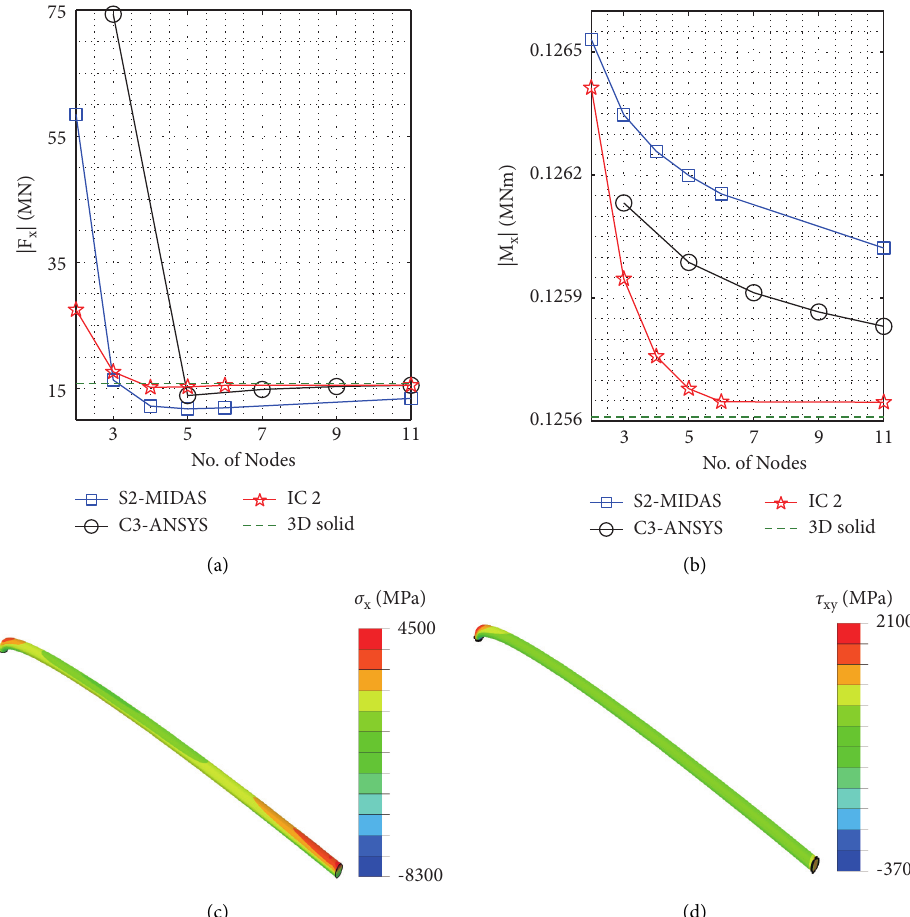
Figure 6: Influences of element types and no. of divided nodes on the numerical solutions of (a) | F contours from the 3D solid finite element analysis: (c) σ x and (d) τ xy